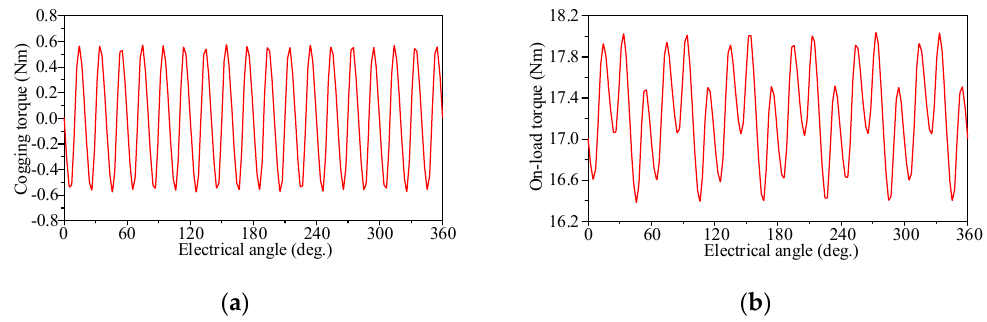
Figure 15. Torque performance of CPMM. ( a ) Cogging torque. ( b ) On-load torque.